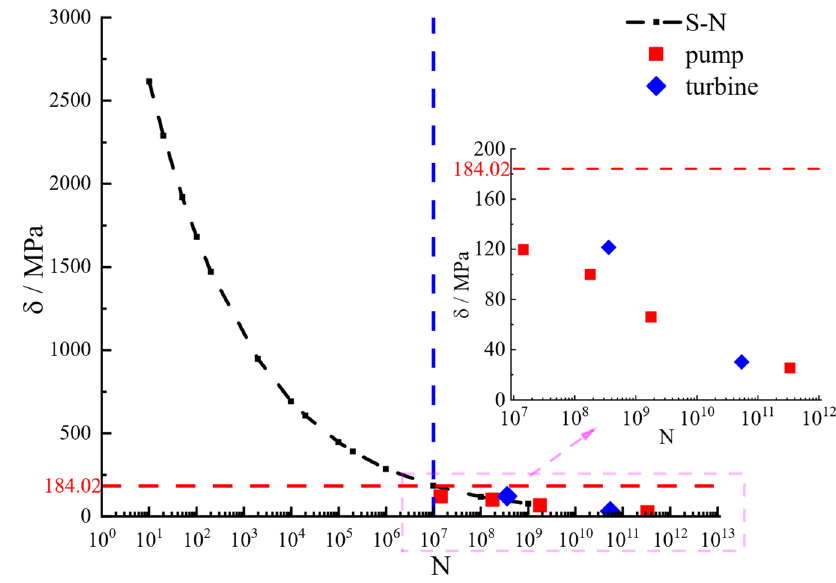
Figure 16. Fatigue characteristic curve of the ZG06Cr13Ni4Mo material.